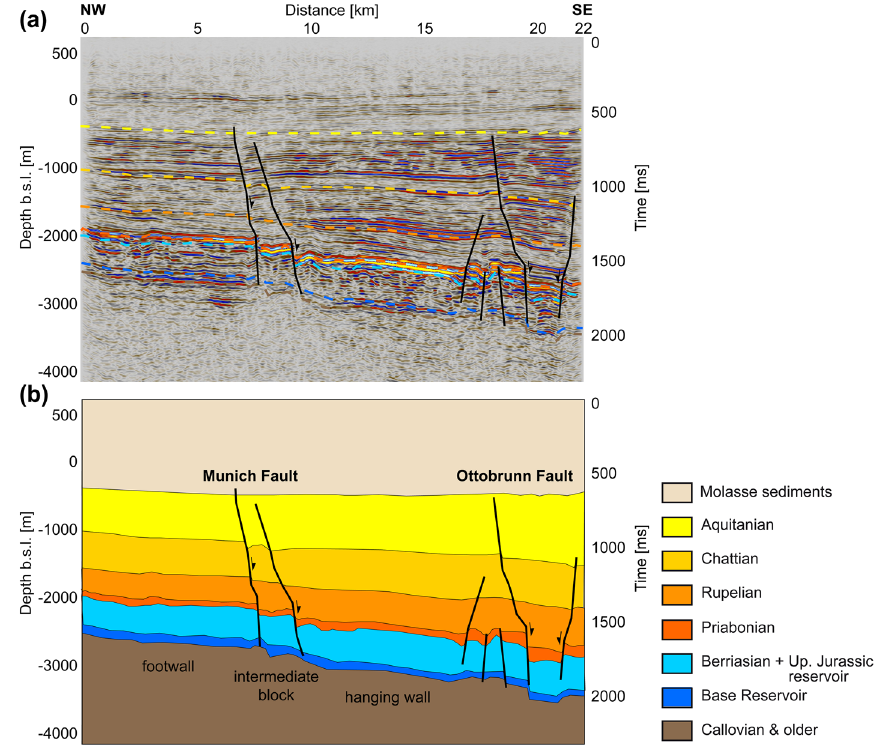
Fig. 4 Cross section through the GRAME 3D seismic intersecting the Munich Fault ( a ), and the corresponding geological interpretation ( b ). In the Schäftlarnstraße area the Munich Fault splits into two branches resulting in a three-part fault geometry which consists of a hanging wall, an intermediate block and a